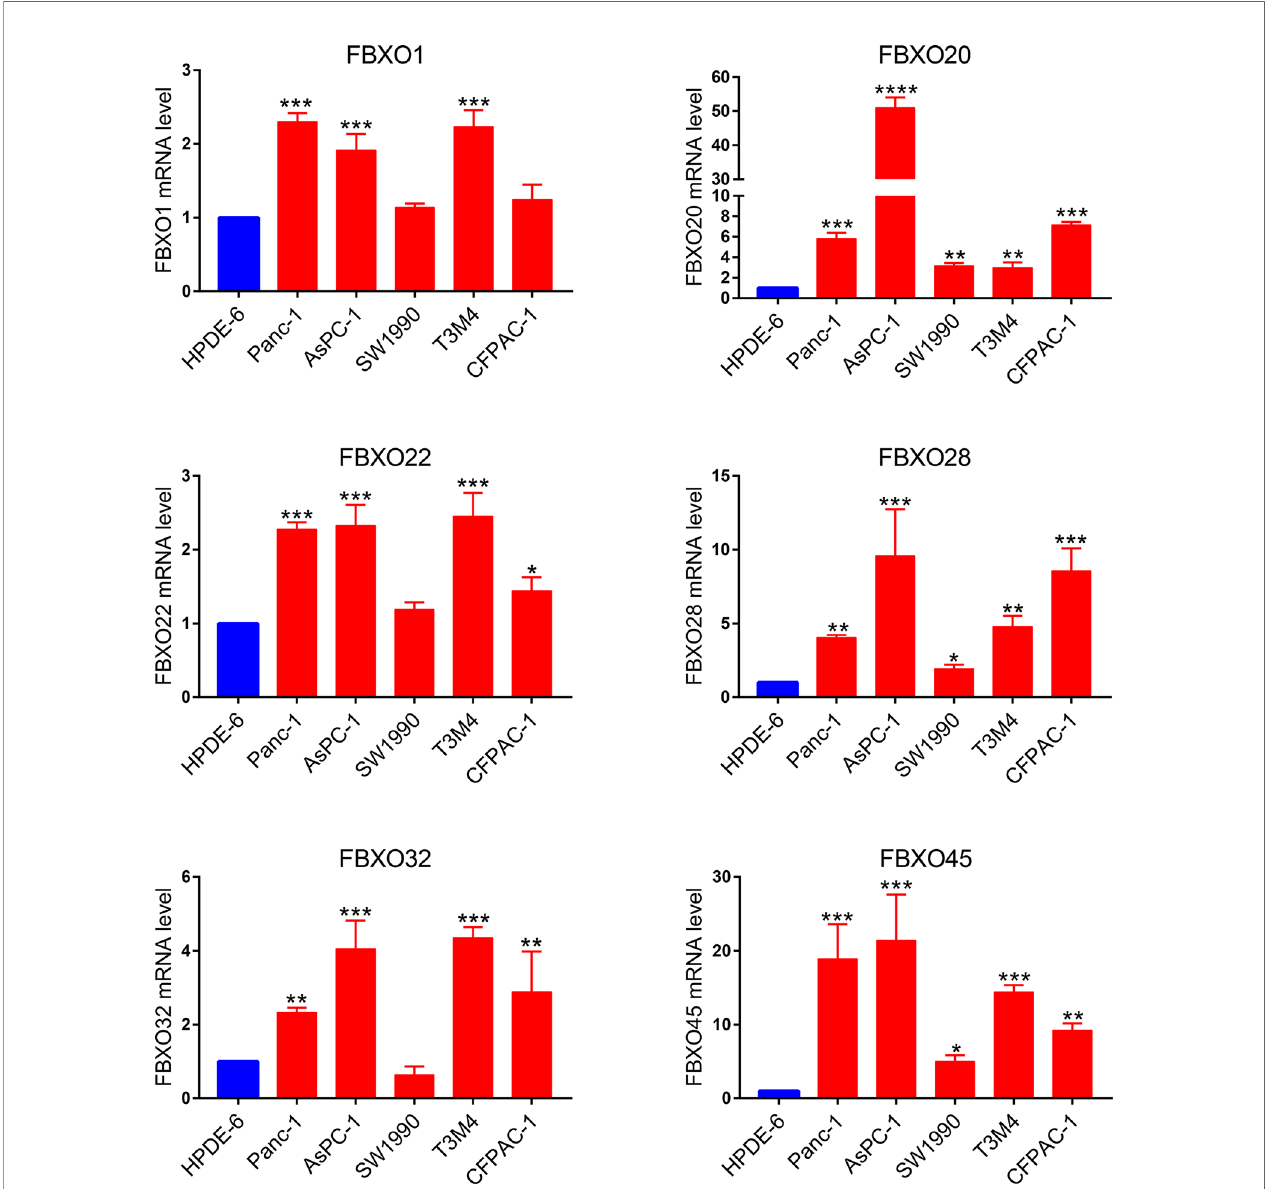
FIGURE 9 | The expression levels of six-FBXOs in human immortalized normal pancreatic epithelial cells HPDE6 and different pancreatic ductal adenocarcinoma cell lines were veri fi ed using real-time qPCR. * P < 0.05, ** P < 0.01, *** P < 0.001, **** P <